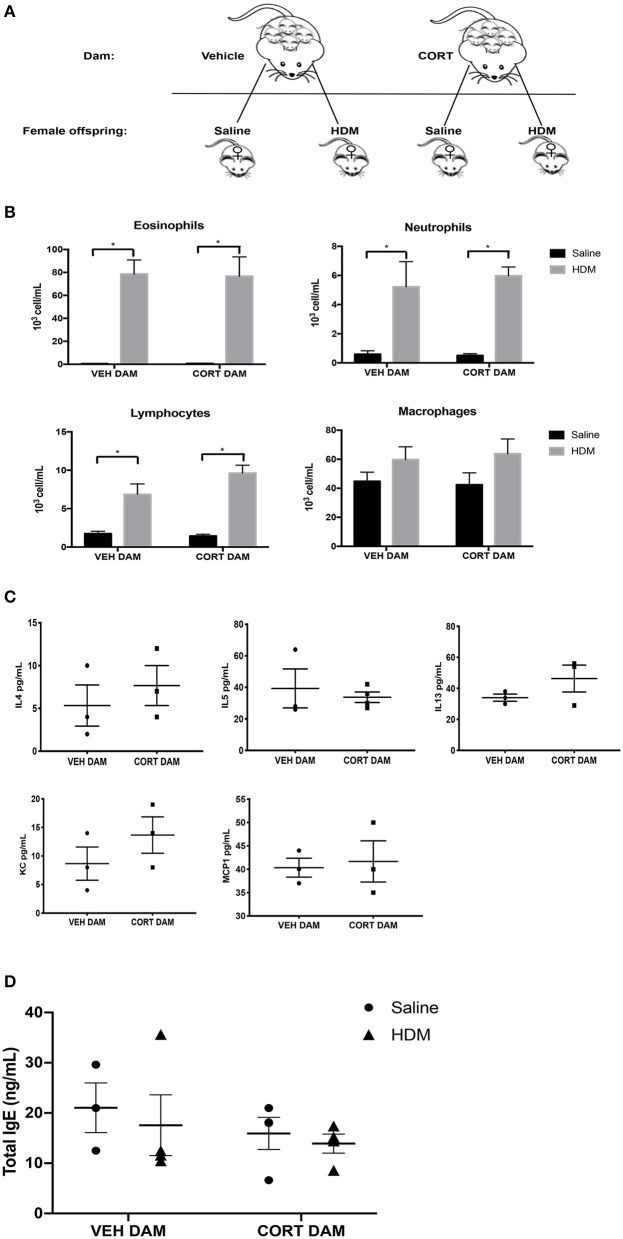
Pulmonary immune cells, cytokines and total serum IgE in female offspring from vehicle and CORT-treated dams. (A) Schematic representation of dam and offspring treatments. Pregnant females received corticosterone (CORT) or vehicle in g water at E12.5 until the end of pregnancy. Female offspring from CORT and vehicle treated dams were treated with saline or HDM consisting of 135 μg of the major allergen Der p 1. (B) Immune cells were quantified, total number of eosinophils, neutrophils, lymphocytes, and alveolar macrophages in BAL of female offspring from vehicle or CORT-treated dams, treated with HDM or saline (n = 5–9). (C) Cytokine and chemokine concentrations in BALF were compared between HDM-treated female offspring from vehicle and CORT-treated dams. Interleukin-4, IL-5, IL-13, KC, and MCP-1 concentrations are reported as pg/mL in BALF. (D) Total IgE in serum of female offspring treated with saline (circle) and HDM (triangle), with concentrations reported as ng/mL (n = 4). * p < 0.0001.